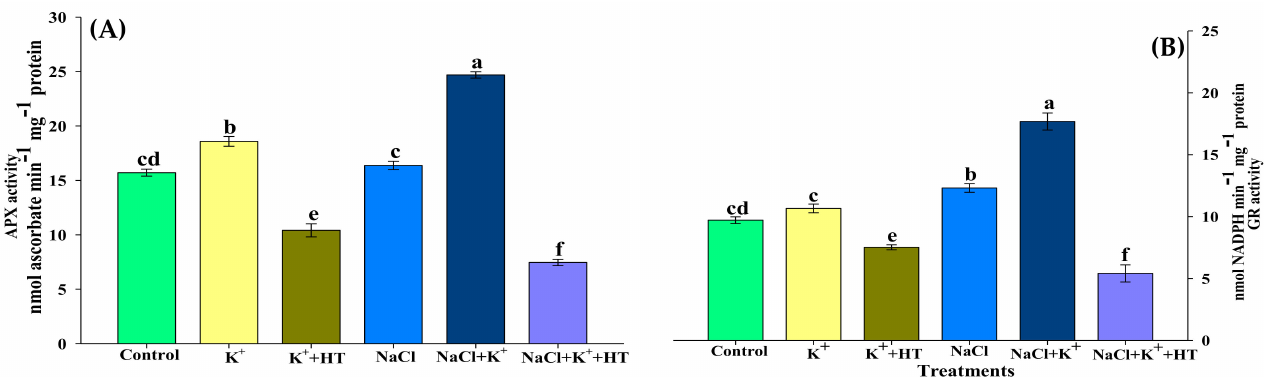
Figure 7. Effect of K + and NaCl on the enzymatic components of ascorbate–glutathione cycle in tomato seedling roots. ( A ) Ascorbate peroxidase (APX) activity and ( B ) glutathione reductase (GR) activity. Double deionized water (control), 5 mM K 2 CO 3 (K + ), 100 mM NaCl (NaCl), 1 mM hypotaurine (HT: H 2 S scavenger). Values are means of five independent replicates, with bars indicating SE. Bars with different letters indicate that differences were statistically significant at p < 0.05